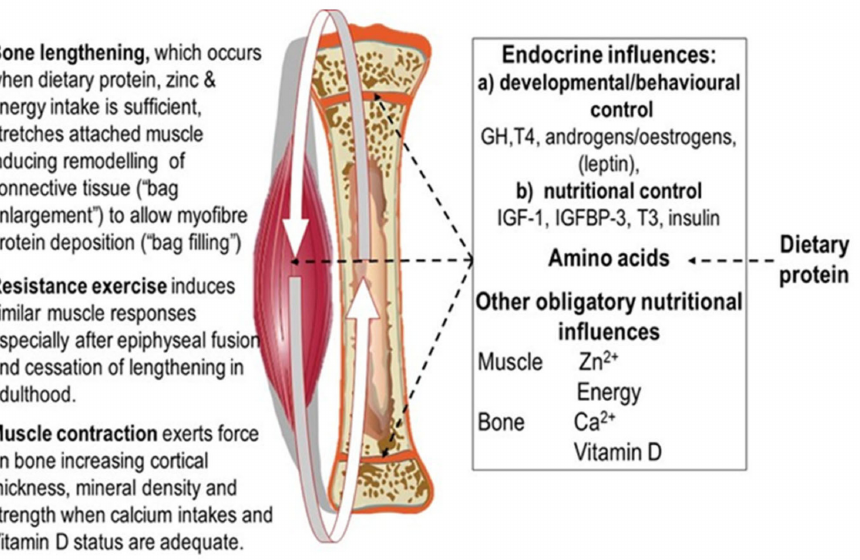
Figure 1. Dietary protein and appendicular muscle- bone